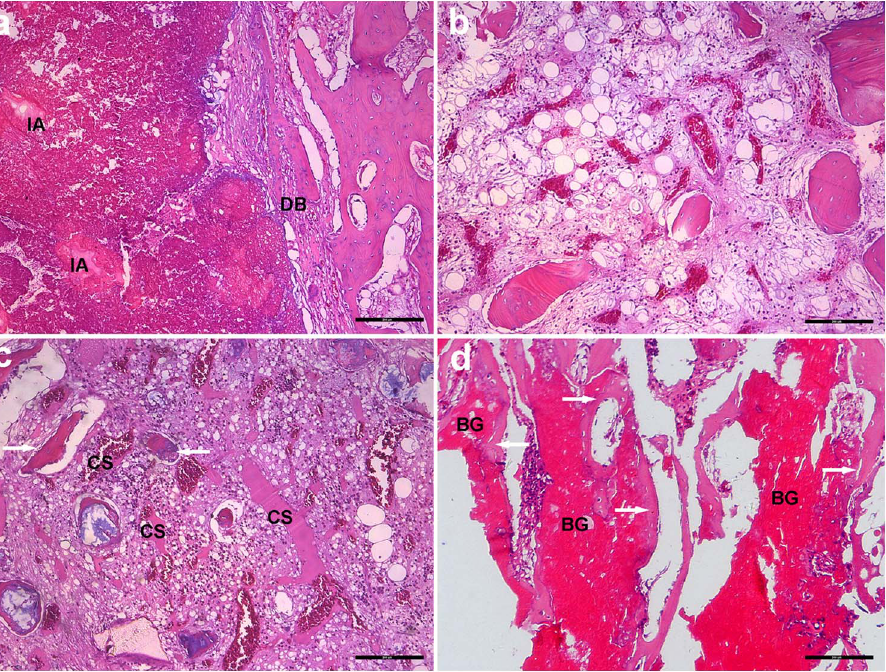
Figure 9. Representative images of H&E stained sections of rabbit tibiae at 2 months post-surgery. (a) Group 1 (no treatment): Typical signs of osteomyelitis, including destruction of bone (DB), intramedullary abscess (IA), with virtually no new bone formation; (b) Group 2 (intravenous injection of vancomycin): no typical signs of osteomyelitis and little new bone formation; (c) Group 3 (vancomycin-loaded CS cement): the CS cement was mostly degraded with only limited new bone formation (white arrow) surrounding it, and some macrophages near the degraded material (CS); (d) Group 4 (vancomycin-loaded borate BG cement): a considerable amount of new bone (white arrow) was formed which was in direct contact with the degraded implant (BG). (Bar =200 m